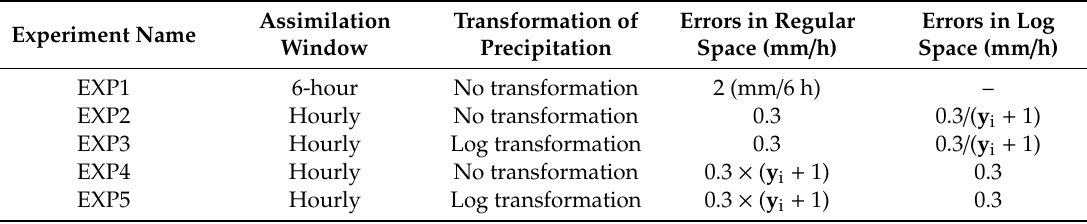
Figure 3. Scatter plot of hourly domain-mean observed precipitation and open-loop estimated precipitation (mm/h).